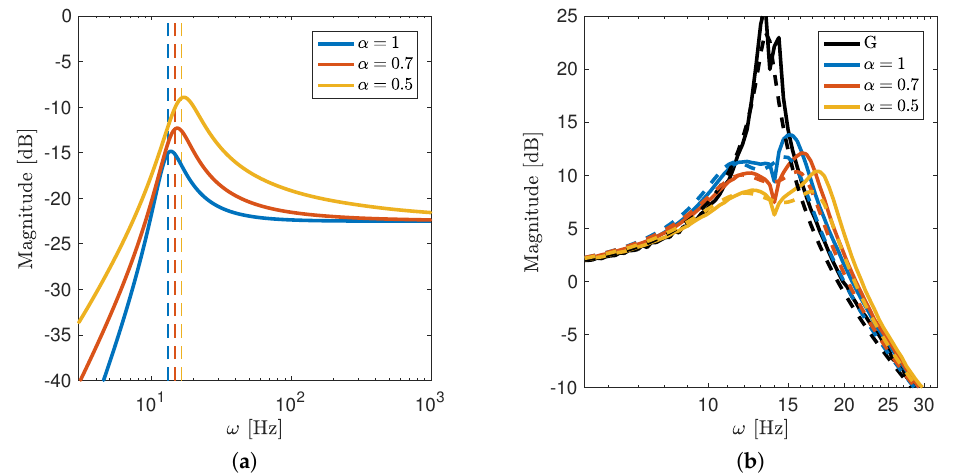
Figure 9. Implemented controllers ( a ) and compassion of frequency responses ( b ) obtained from experiments. Dashed (–) and solid (-) lines in (b) present the predicted and measured responses, respectively.